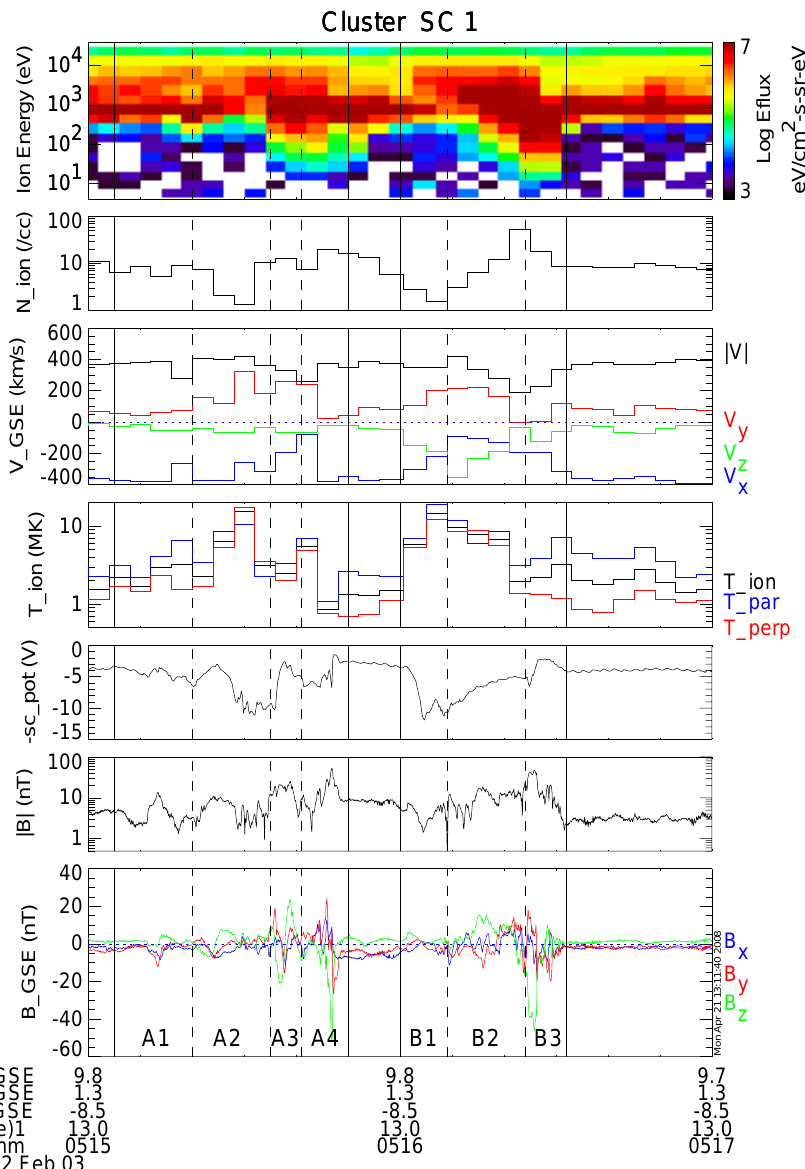
Fig. 1a. Observations of Cluster 1 on 3 February 2002, 05:15–05:17UT. From top to bottom: (1) Energy spectra of ion flux from CIS-HIA instrument; (2) The ion density; (3) Velocity components in GSE coordinates: V x (blue), V y (red), V z (green) and the total velocity (black); (4) The ion temperature (black) overplotted with temperature components in directions parallel (blue) and perpendicular (red) to the magnetic field; (5) Negative spacecraft potential as a proxy for the electron density; (6) The magnetic field strength; (7) Magnetic field components in GSE coordinates: B x (blue), B y (red), B z